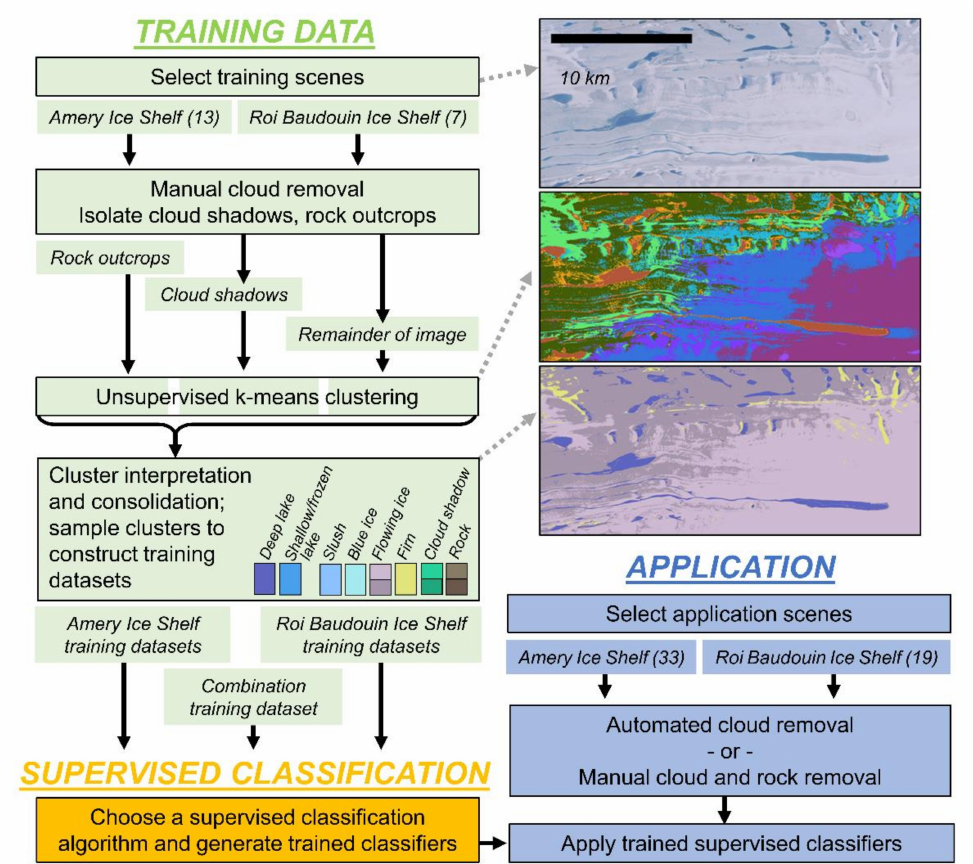
Figure2. Schematicworkflowforcreatingtrainingdata(green), generatingtrainedsupervisedclassifiers (orange) and applying the classifiers over Amery and Roi Baudouin ice shelves (blue). Landsat product ID and sun elevation for each training and application scene used in this study are provided in Table